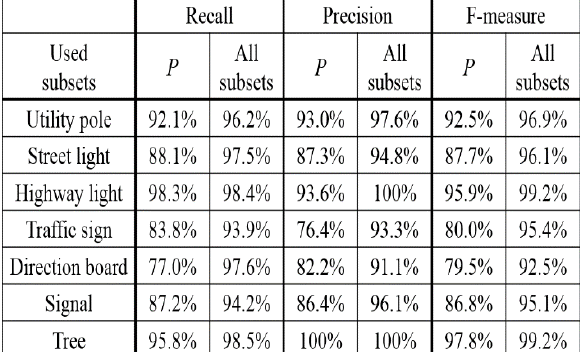
Table 4. Recognition rates for feature variables of all subsets and only